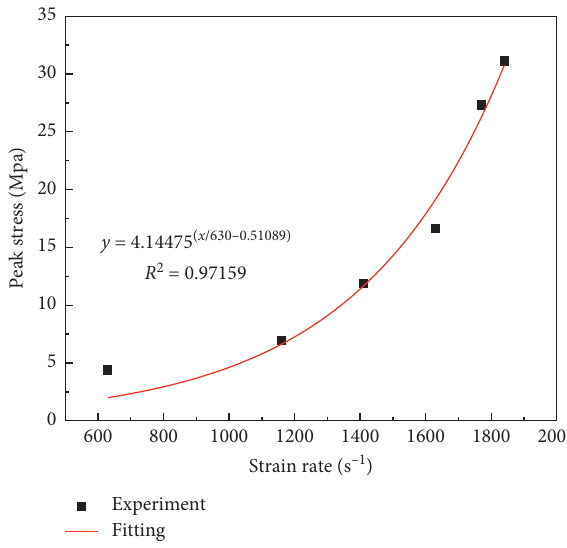
Figure 6: Peak stress at different strain